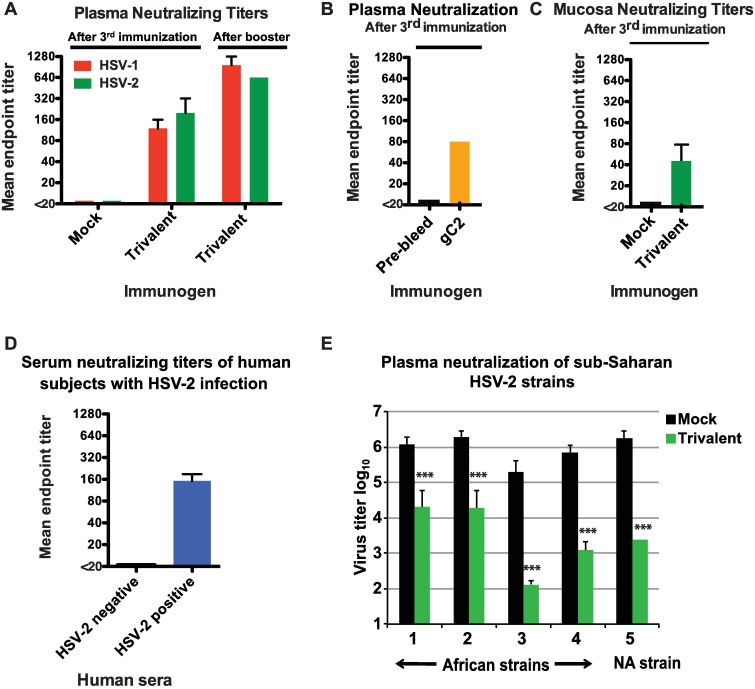
Rhesus neutralizing antibody responses.(A) Plasma neutralizing titers induced by the trivalent vaccine against HSV-1 and HSV-2 after the third immunization at week 12 and after a booster dose at week 40. (B) Neutralizing antibody titers induced by gC2 alone after the third immunization. Results are the mean of two animals. Pre-bleed represents serum obtained prior to the first gC2 immunization. (C) Mucosa neutralizing antibody titers to HSV-2 after the third immunization. Results are the mean and SEM of two animals. (D) Serum neutralizing antibody titer to HSV-2 in 10 human HSV-2 seropositive subjects with chronic HSV-2 infection and three HSV-2 seronegative controls. (E) Neutralization of sub-Saharan HSV-2 strains and a North American strain. 105 to 106 PFU of four HSV-2 strains from Uganda, Africa and one from North America (NA) were incubated with plasma from one mock (after the third immunization at week 12) or one trivalent-immunized animal (after the booster dose at week 40). Results represent the mean + SEM of three separate determinations. P values were calculated using mixed effects models to compare the mean responses. Repeated tests within an animal were adjusted for using a nested correlation structure. Sidak p-values were calculated to adjust for the multiple comparisons. *** indicates P<0.001.